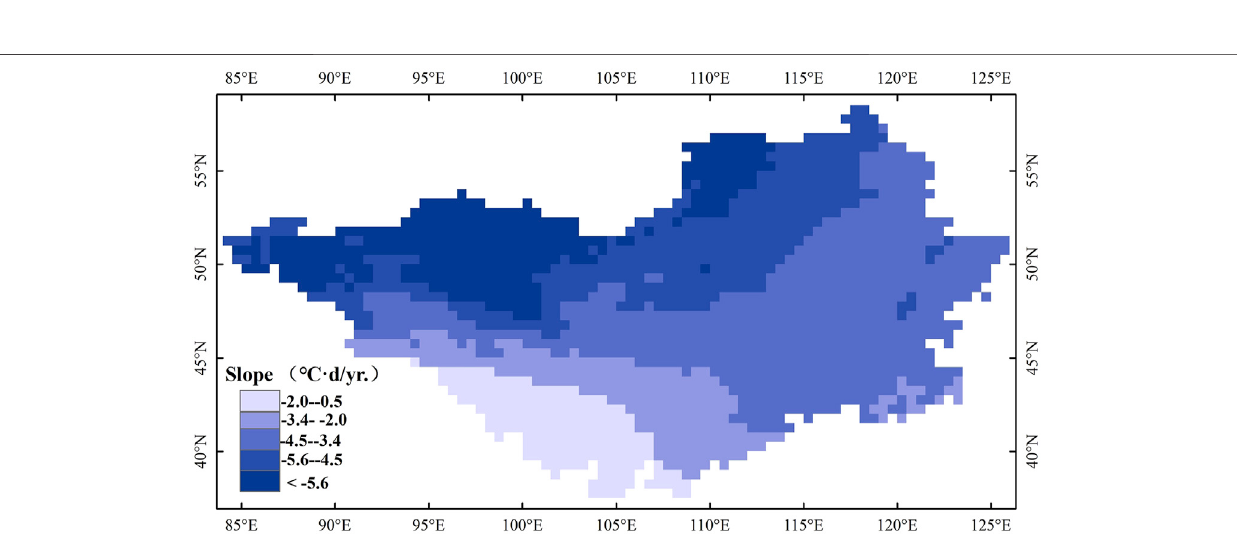
Frontiers in Environmental Science |